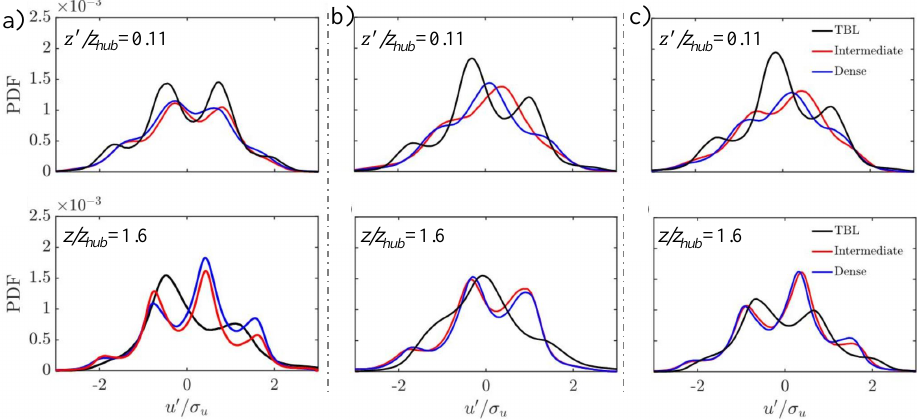
Figure 10. Probability density functions, PDFs, of the normalized streamwise velocity fluctuations, u (cid:48) / σ u , at ( a ) incoming flow, ( b ) x / d T = 3, and ( c ) x / d T = 6.5; z (cid:48) is the relative height with respect to the topography top.